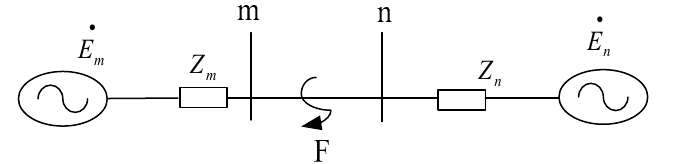
Figure 2. Double-ended power systems. ponent method,